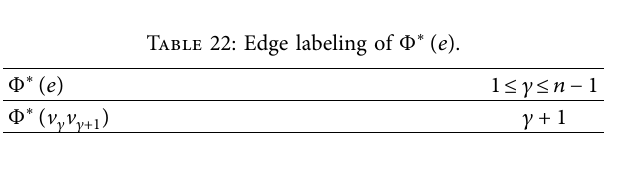
Table 23: Vertex labeling of Φ ( v ).